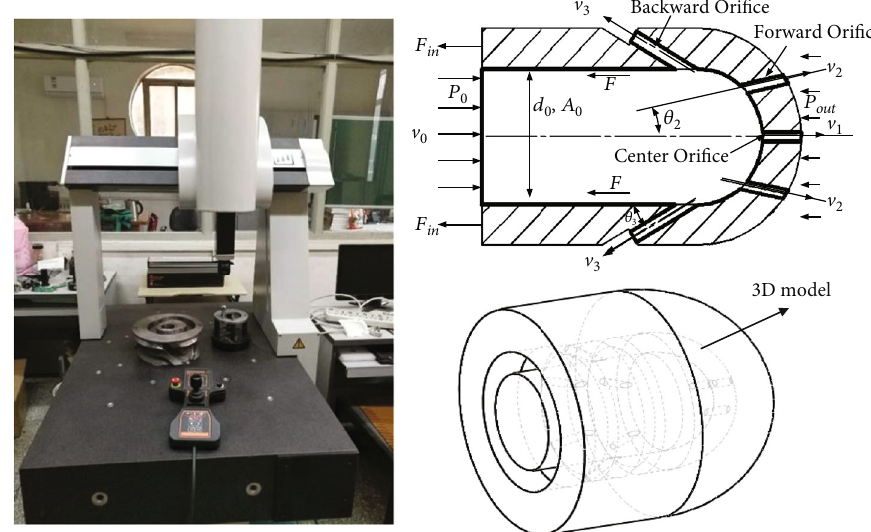
Figure 2: The 3D physical geometry model of the nozzle through three-coordinate measuring instrument.